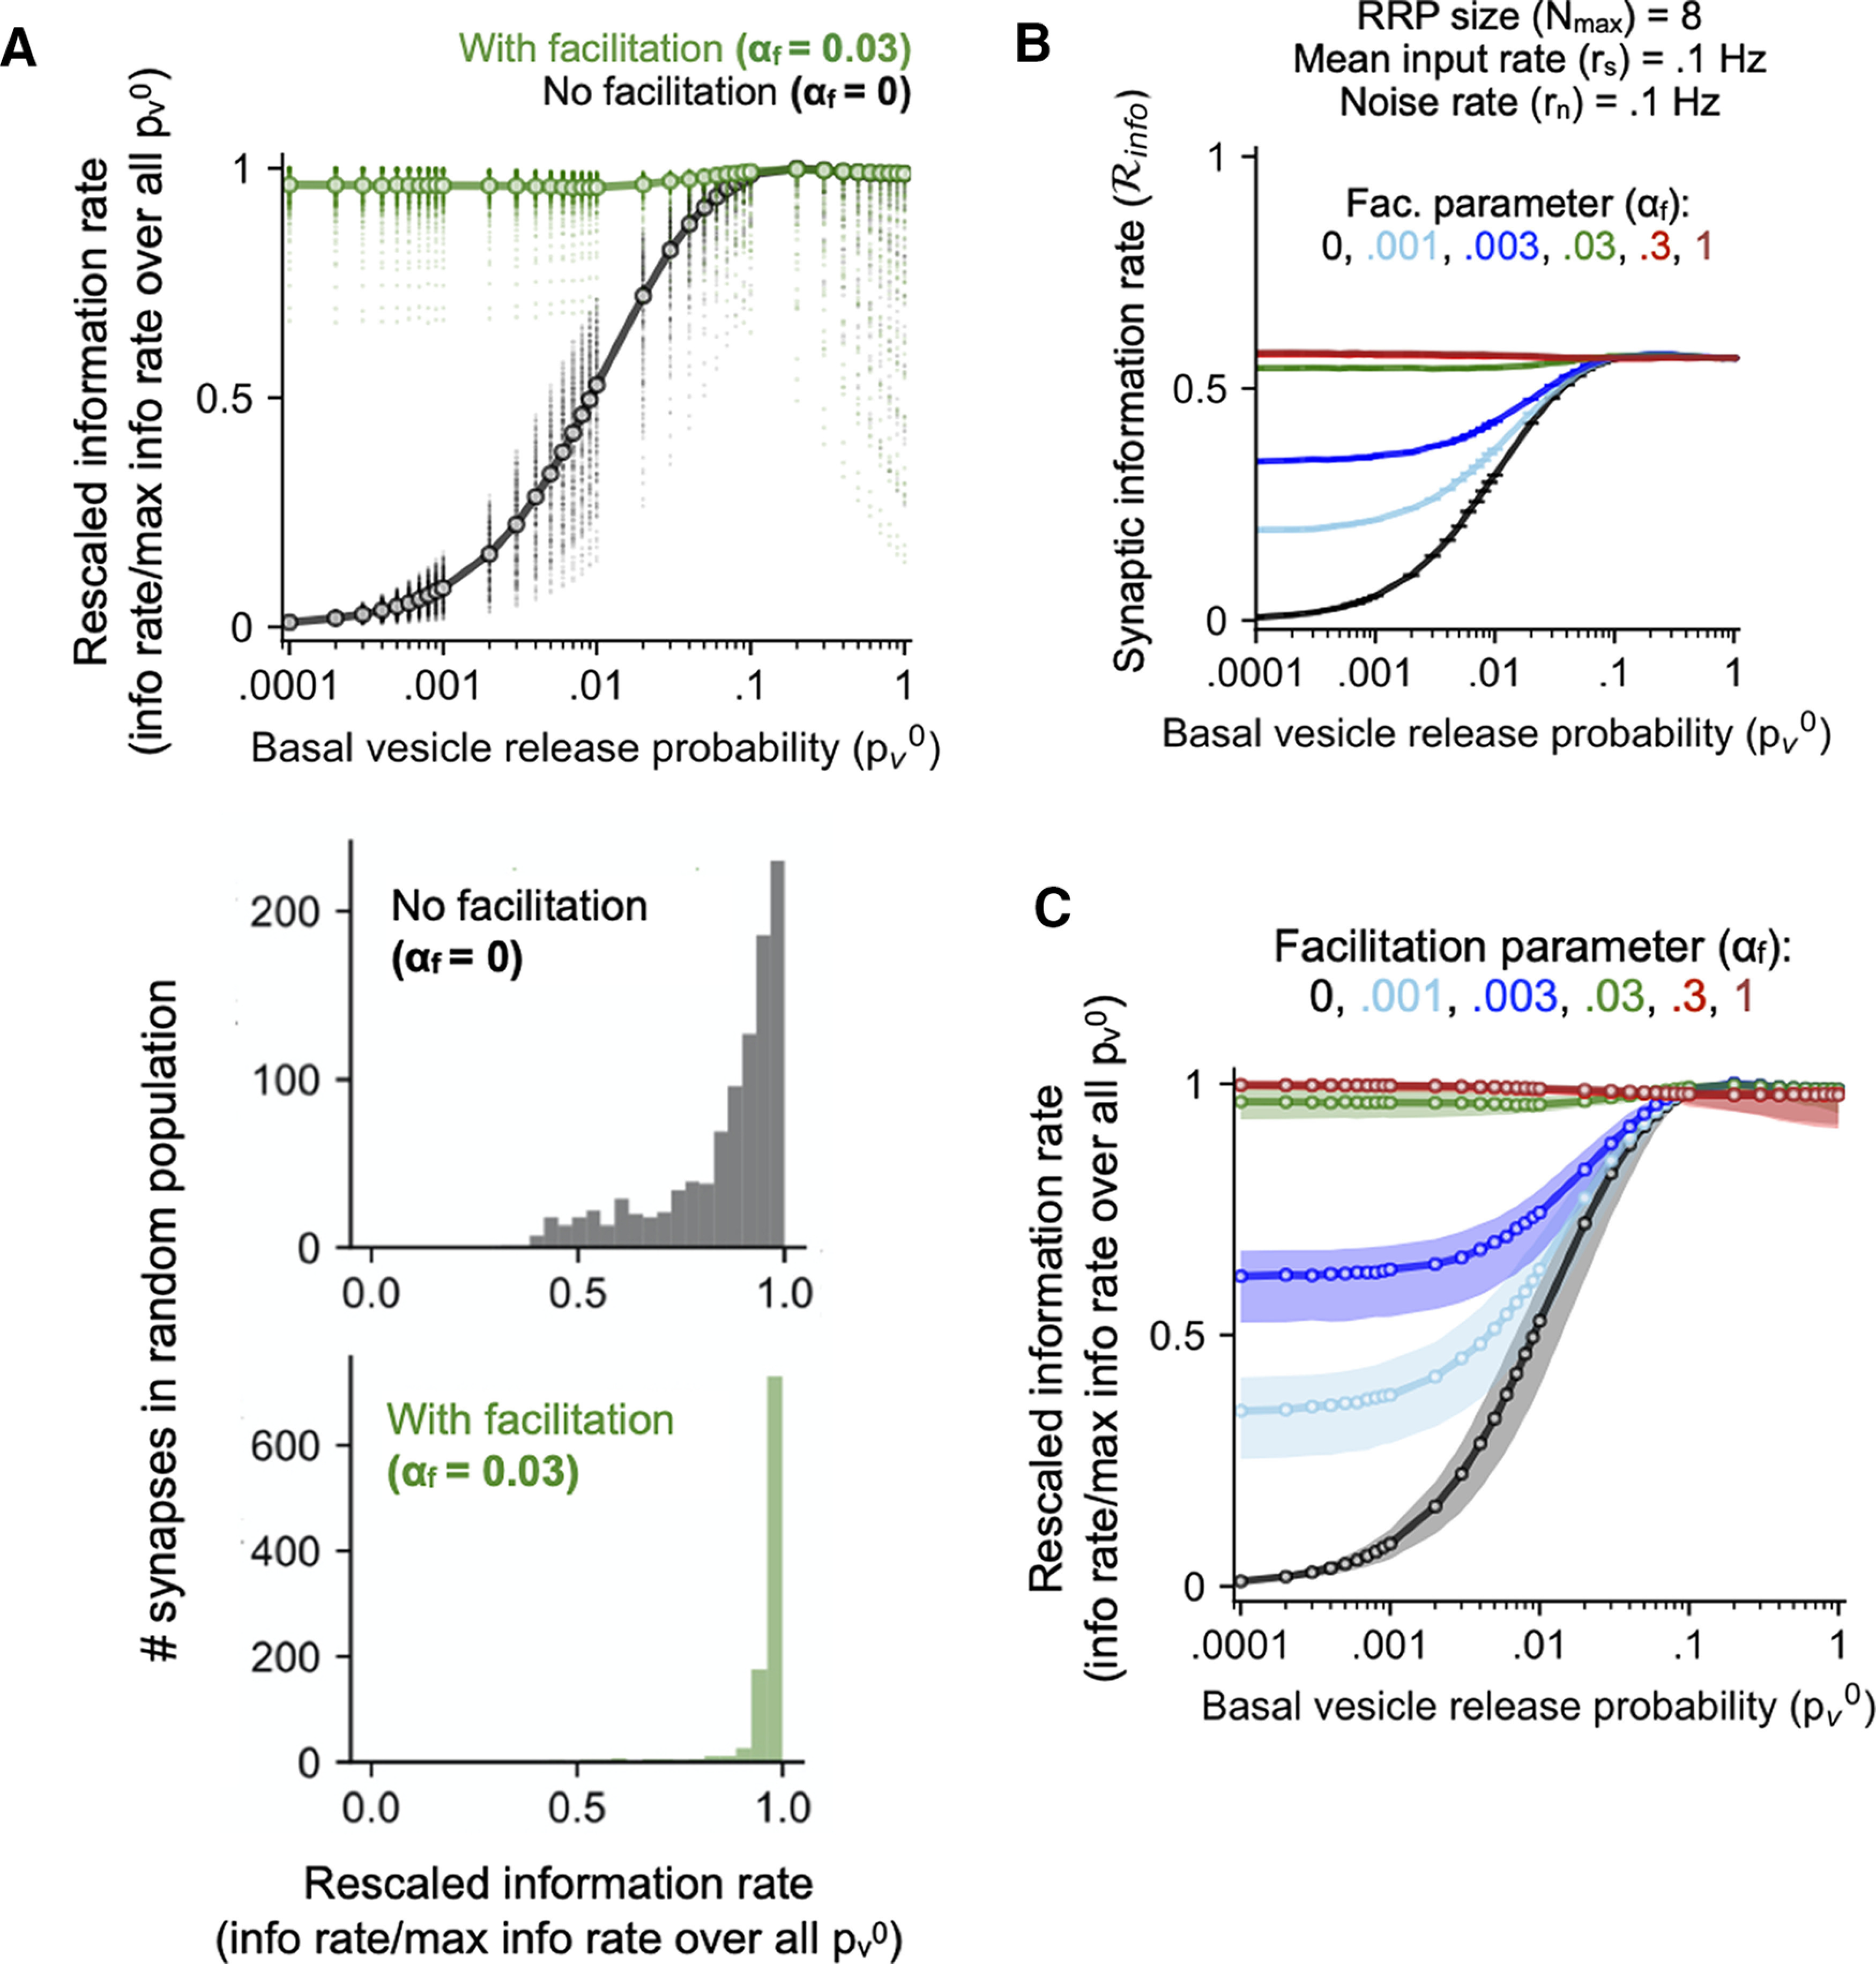
Information transmission properties in an ensemble of facilitating CA3-CA1 synapses. A, top, Dependence of information rate estimates (rescaled values) on the basal probability of vesicle release (pv0) for synapses with physiological facilitation strength (green) and non-facilitating synapses (black) over a realistic range of input/model parameters (for details, see Materials and Methods). Every point represents a distinct parameter combination, and continuous lines connect the medians (one per value of pv0). Bottom, Distribution of rescaled information rates in a representative population of static (black) and facilitating (green) synapses with variable per-vesicle basal release probability (pv0; n = 1000 synapses, randomly sampled from 0.05 ≤Ps0≤0.6 and 1 ≤Nmax≤ 15; input rate and noise rate were also randomly set for each synapse). B, Estimated time-averaged information transfer rate as a function of the initial per-vesicle release probability (pv0) for synapses with different levels of facilitation (approximately three decades in the facilitation parameter αf). Results shown as mean ± SEM (20 independent trials) for each choice of αf. Nmax = 8; rate of burst occurrences = noise rate = 0.1 s–1. The non-facilitating static synapse is shown in black. C, Distributions of rescaled information rates over a realistic range of inputs/model parameters for different magnitudes of the synaptic gain αf (0.001–1). Each distribution is displayed in terms of the medians and 25th –75th percentile (interquartile) ranges (per value of pv0).